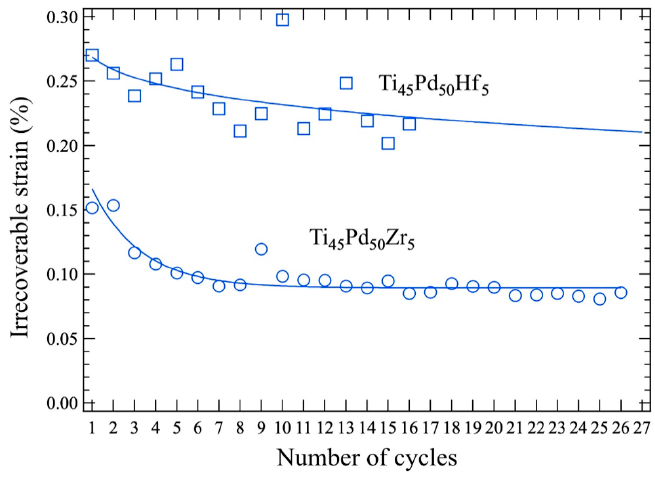
Figure 6. Irrecoverable strain of Ti 45 Pd 50 Zr 5 and Ti 45 Pd 50 Hf 5 as a function of number of thermal cycles under 50 MPa.